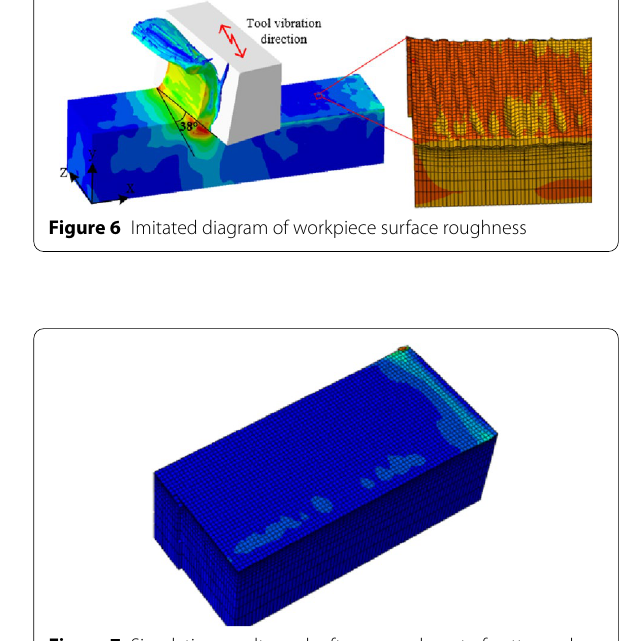
Figure 7 Simulation result graph after concealment of cutter and